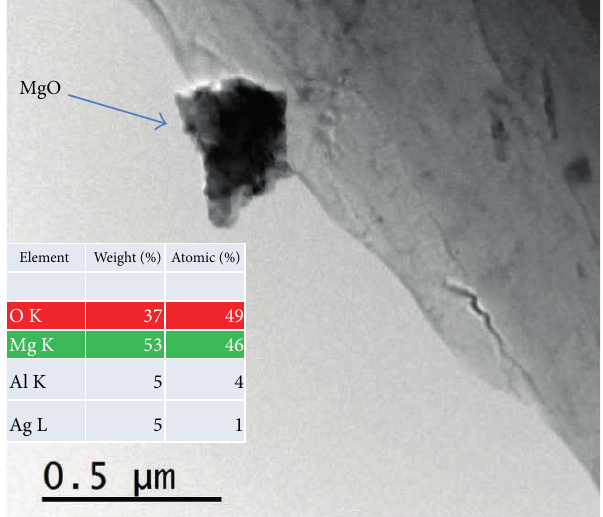
Figure 6: BF TEM of MgO particle in AZ91 + Al 2 O 3